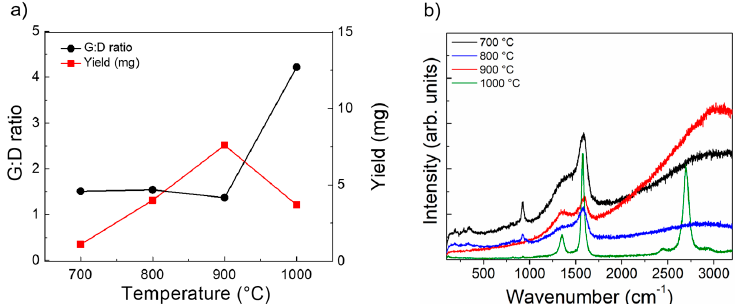
Figure 5. Plot of the Raman G:D ratio (black) and product yield (red) for DLICVD experiments with variable growth temperature ( a ) with the corresponding Raman spectra ( b ). Experiments were performed with an aspiration temperature of 225 °C, a 1 mL/h injection rate, a 1.25 wt.% catalyst concentration, using EtOH as a carbon source.